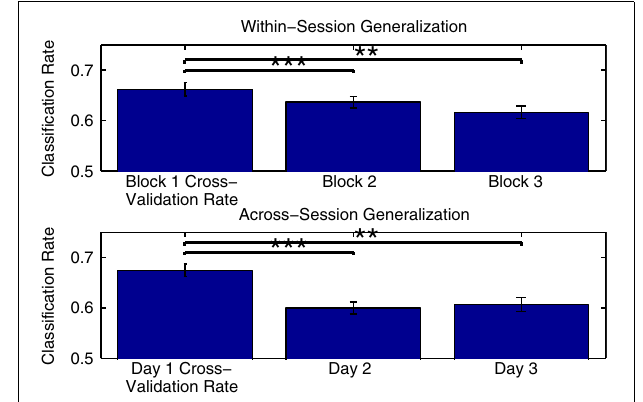
FIGURE 10 | Within-participant generalization across measurement blocks and sessions. The ability of classifiers trained on individual data to generalize to novel data collected during either the same or in different measurement sessions was evaluated using Dataset 2. In the within-session analysis, classifiers were trained using data collected in the first measurement block and then tested using data from the second and third blocks. In the across-session analysis, classifiers were trained using data from all three blocks measured in the first session, and tested using the initial blocks measured in the second and third sessions. For both analyses, a significant drop in performance was observed relative to the cross-validation rates obtained when training the classifiers. The significance of these paired-sample t -test comparisons is indicated using asterisks: ∗∗ p < 0 . 01, ∗∗∗ p < 0 . 001. The drop across sessions was more severe, and could be potentially due to a number of factors, including changes related to the placement of electrodes as well as differences in the subjective states of the individual participants on different